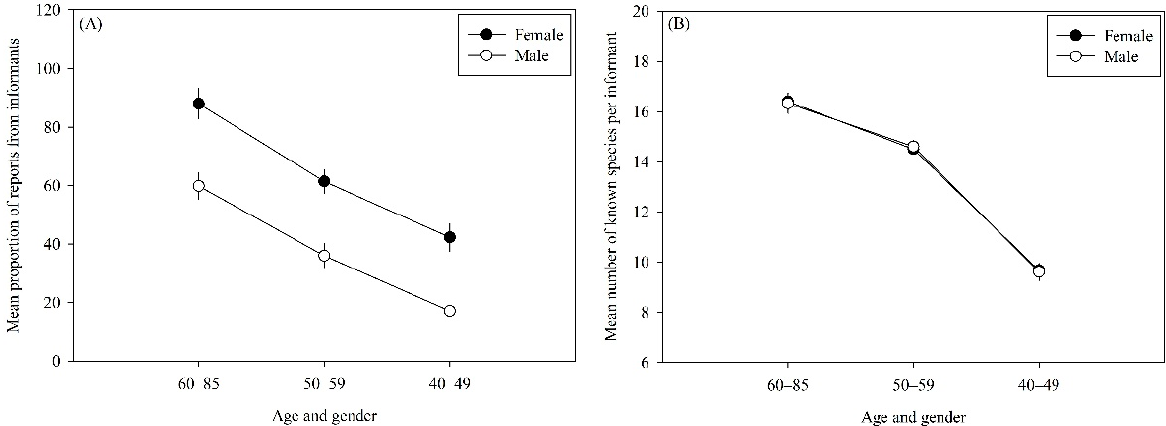
Figure 5. ( A ) Proportion of informants who had knowledge of textile dyeing with local plants and ( B ) mean number of local textile dyeing plants known by each informant. 60 to 85, 50 to 59, and 40 to 49 represent each categorized generation age. Bars represent mean ±SE. The number of textile dye methods and plant species known by selected informants varied by age (Wald = 518.82; df = 2; p < 0.001). The older generation knew more about local plant species than the younger generation did (16.37 ± 0.21 for age ≥ 60, 14.56 ± 0.17 for the age of 50 to 59, and 9.64 ± 0.22 for the age of 40 to 49, Figure 5B). When we asked the informants who knew textile dyeing methods and plants, there was no significant difference in the number of known textile dye plants between genders (13.53 ± 0.14 for female; 13.52 ± 0.19 for male; Wald = 0.003; df = 1, p = 0.958) and the interactions were not significant either (age × gender: Wald = 0.155; df = 2, p =